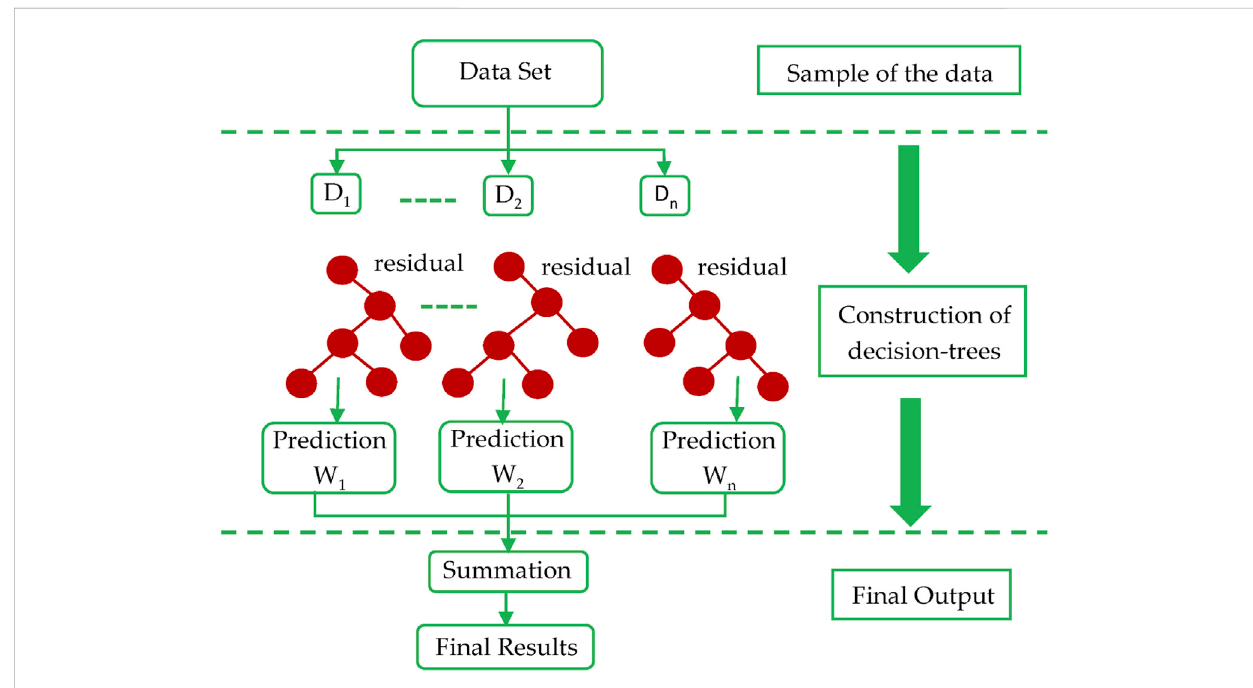
FIGURE 2 Structure of the XGBoost algorithm (Amjad et al., 2022).